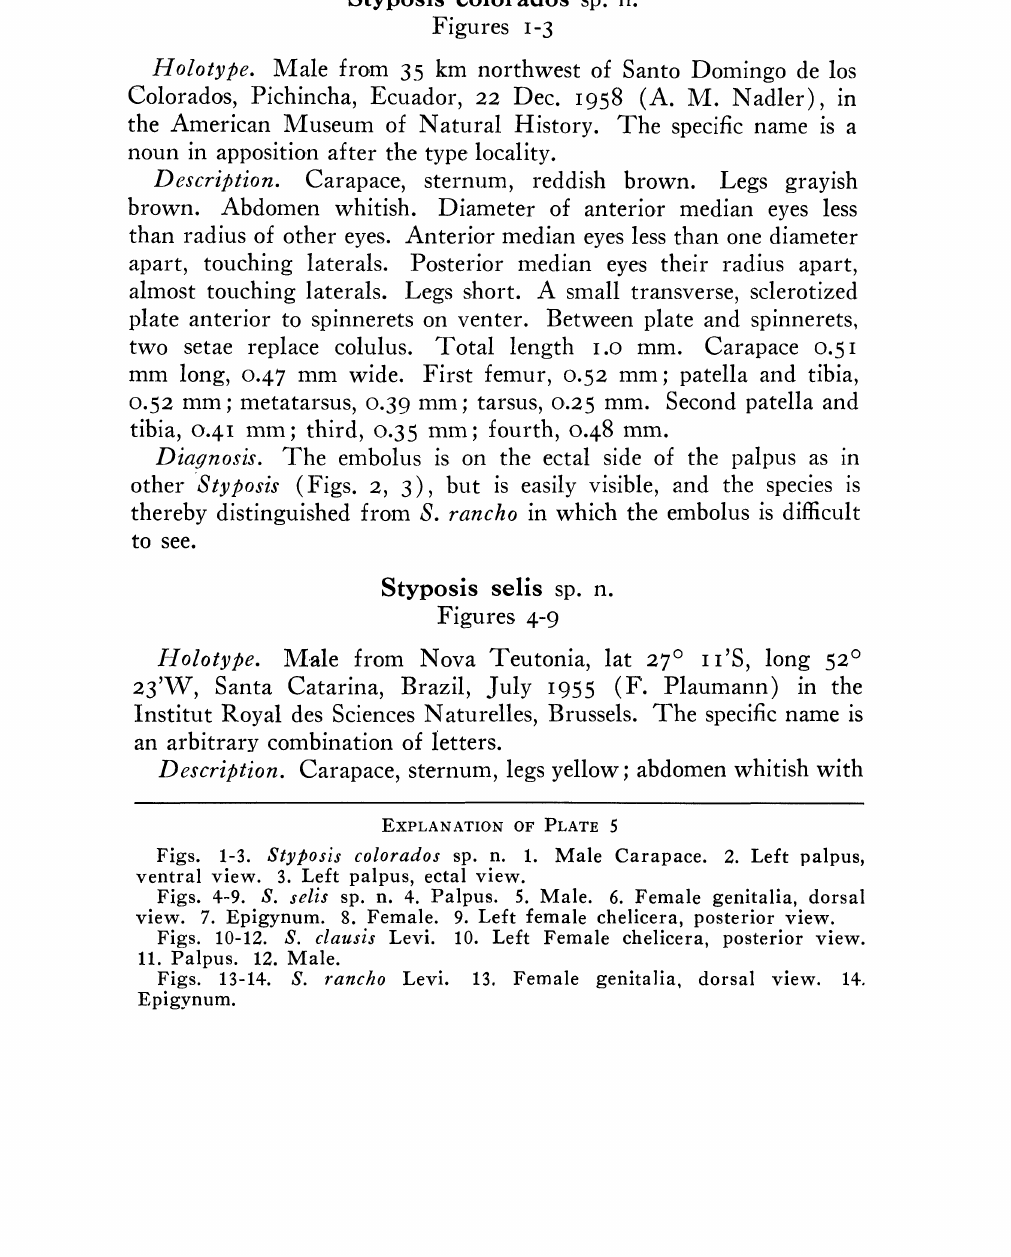
8b. Anterior lateral eyes separated by about one and one-half dia- meters (Fig.